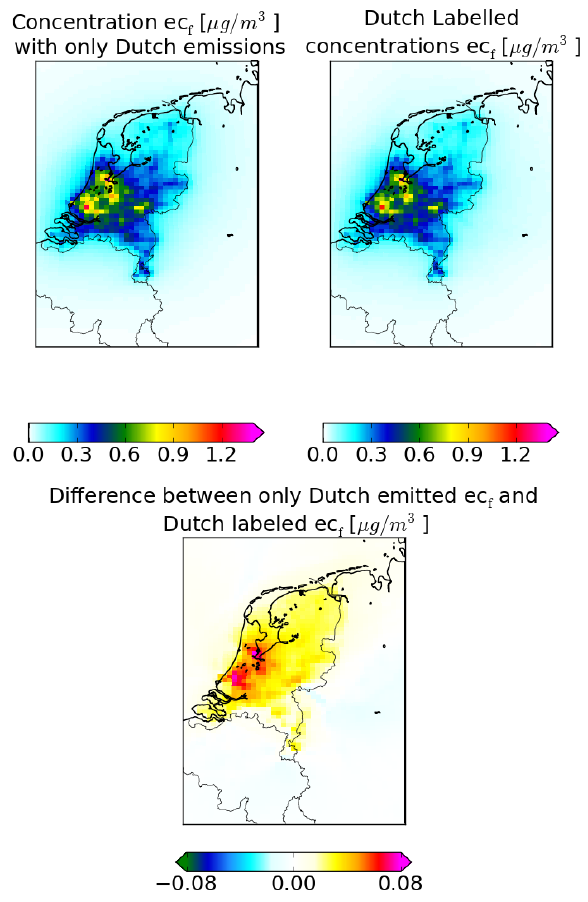
Fig. 2. Upper left: concentration elemental carbon in fine mode (EC f) resulting from a model simulation with only Dutch emis- sions. Upper right: concentration EC f from a full model simulation corresponding to the label on Dutch emissions. Lower: the differ- ence between those two simulations. These simulations are done with the linear processes and the non-linear advection process for the complete year